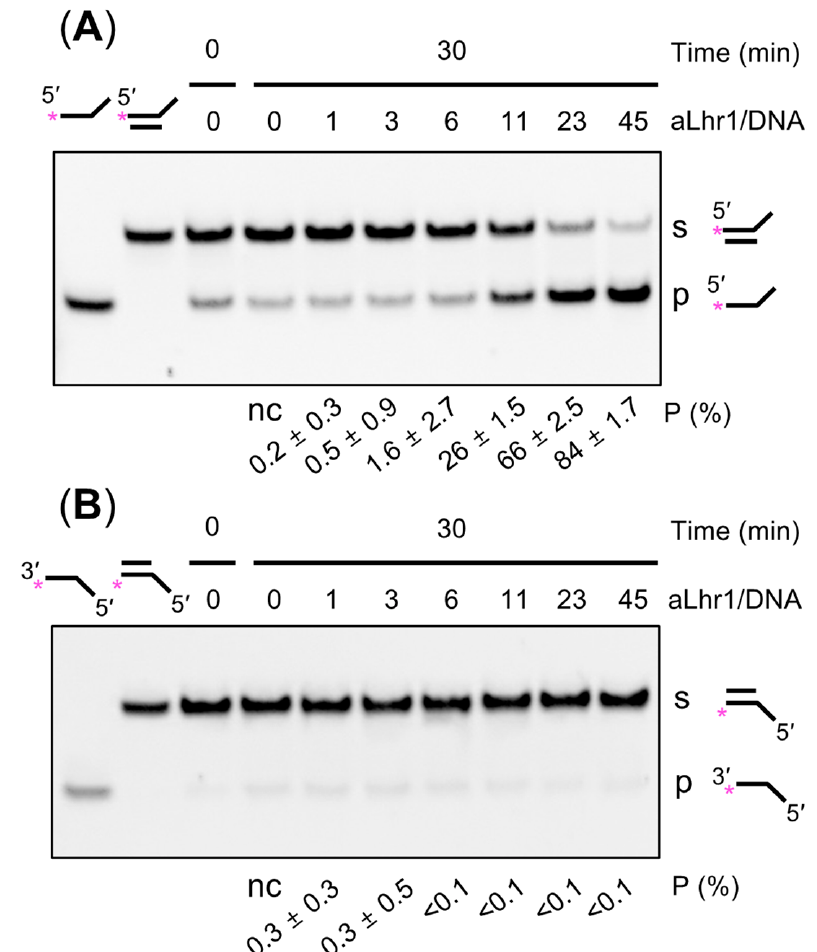
Figure 3. Sac aLhr1 is a 3 ′ -to-5 ′ DNA helicase. We incubated 10 nM of 3 ′ -protruding DNA ( A ) and a 5 ′ -protruding DNA ( B ) with the indicated ratio of Sac aLhr1 and DNA (aLhr1/DNA) at 70 °C for 30 min. Asterisks in ( A , B ) indicate 5 ′ - and 3 ′ -Cy5 labels, respectively. The band assignments are indicated on the right side of the panels (s, substrates; p, products). Reactions were quantified by measuring the band intensities and expressed as P% (product per total DNA) and are indicated under each lane. Value from the negative control reaction without protein (nc, negative control) was subtracted from each value. Data are presented as mean ± SD, calculated from values of three independent experiments.